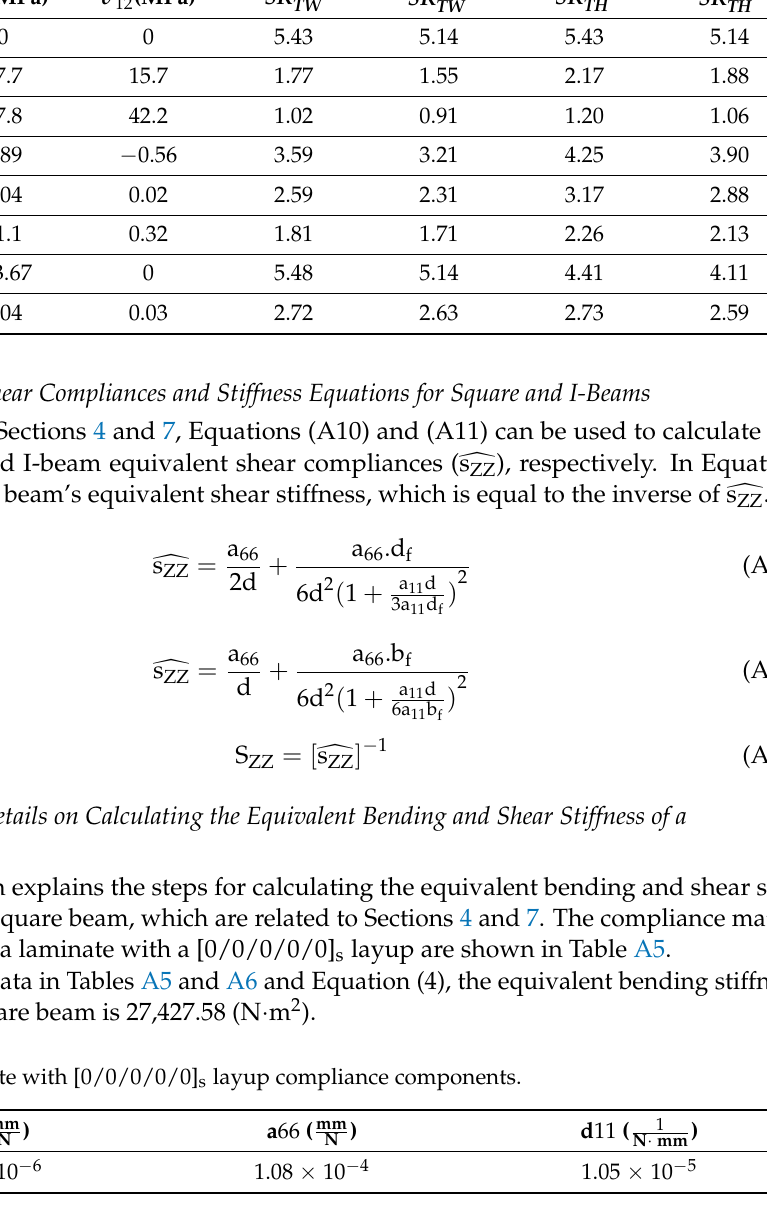
Table A6. Square beam geometrical dimensions (mm) (Note: the cross-sectional details are shown in Figure